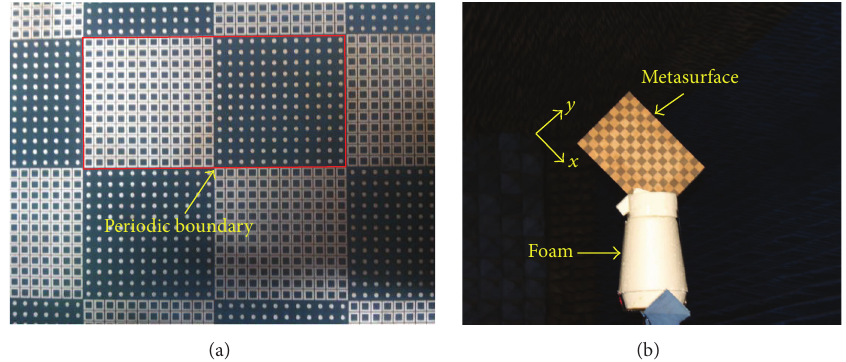
Figure 3: (a) Manufactured metasurface with periodic arrangement. (b) RCS measurement inside an anechoic chamber.